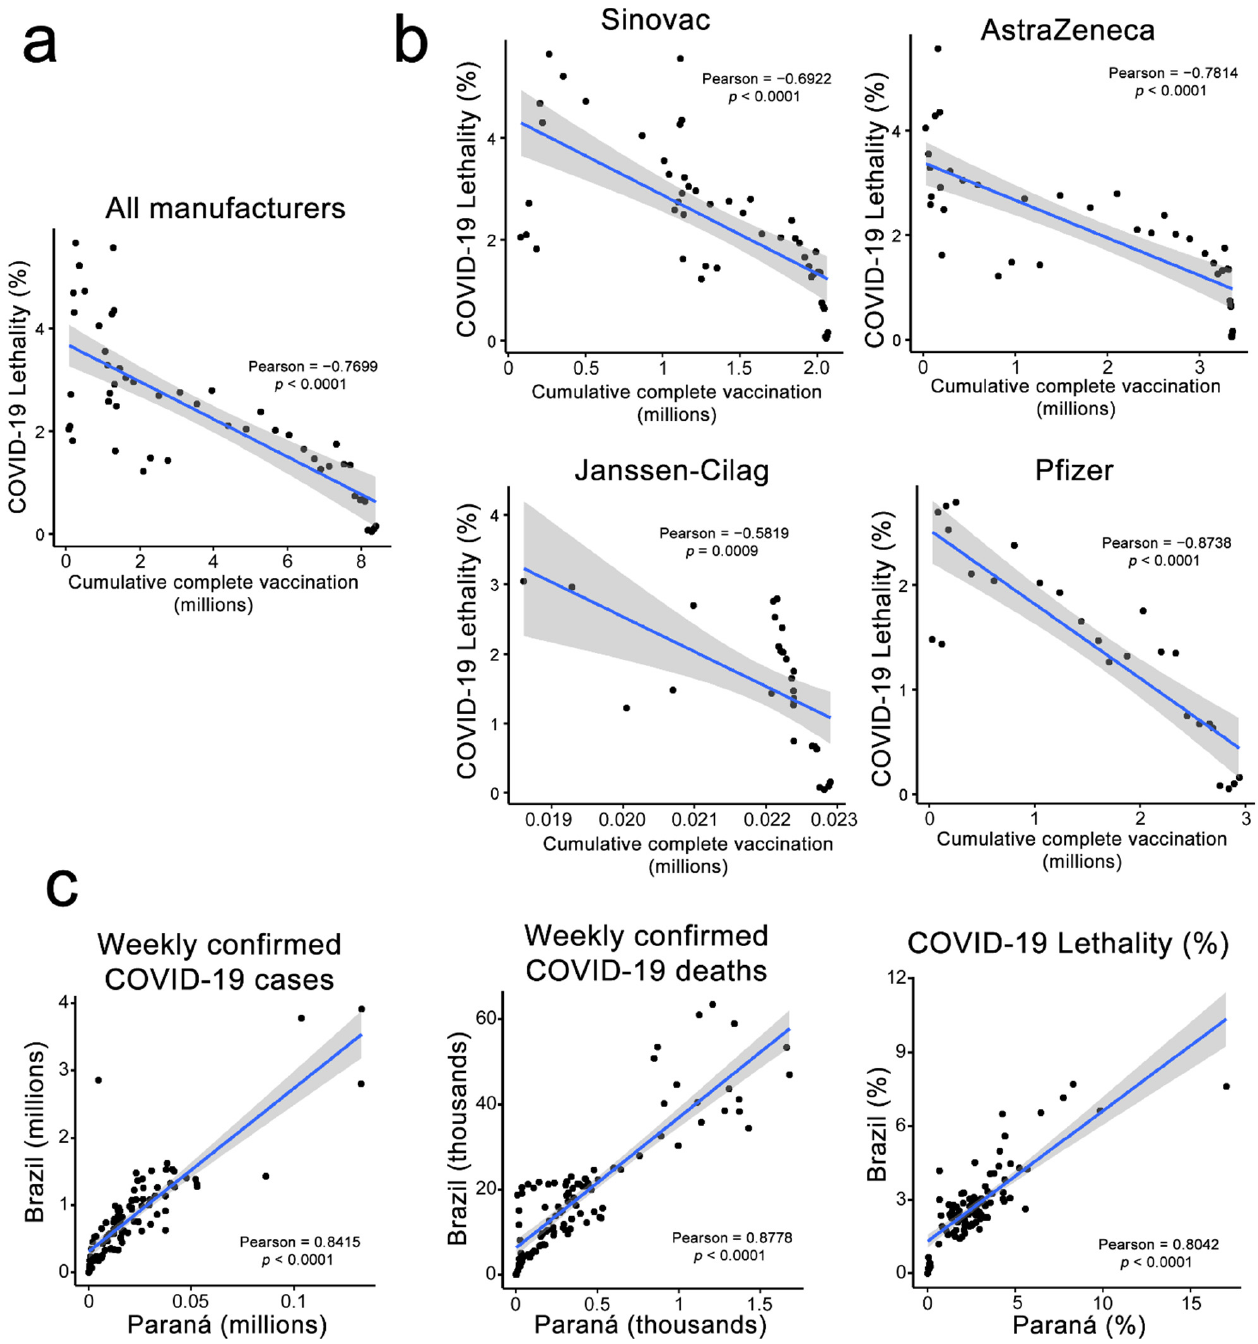
Figure 2. Correlation between vaccination rates and SARS-CoV-2 lethality in Paraná State and comparison with general country infection rates. ( a ) Correlation between cumulative two-doses complete vaccination cycle reported weekly using any vaccine in Paraná state ( x -axis) and COVID-19 disease lethality ( y -axis). ( b ) Same as ( a ), but stratified by each vaccine manufacturer. ( c ) Correlation between Paraná state epidemiological scenario ( x -axis) and Brazil one ( y -axis) for weekly confirmed COVID-19 cases (left), COVID-19 confirmed deaths (middle), and COVID-19 lethality (right). Blue line represents a linear regression; values derive from Pearson correlation and its p -value.